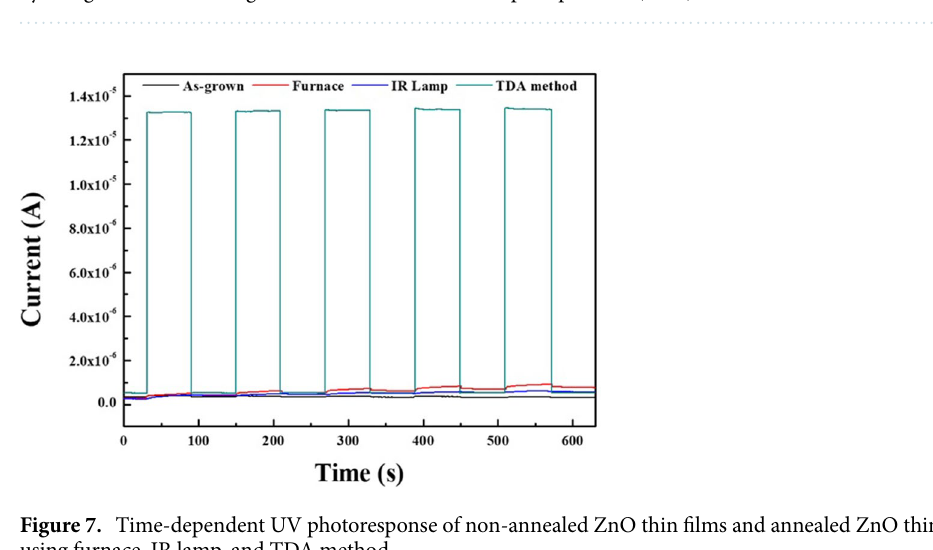
Figure 6. (a) PL spectra and (b) the intensity of NBE emission of sol–gel spin-coated ZnO thin films annealed by using various annealing method, and NBE emission peak position (inset).